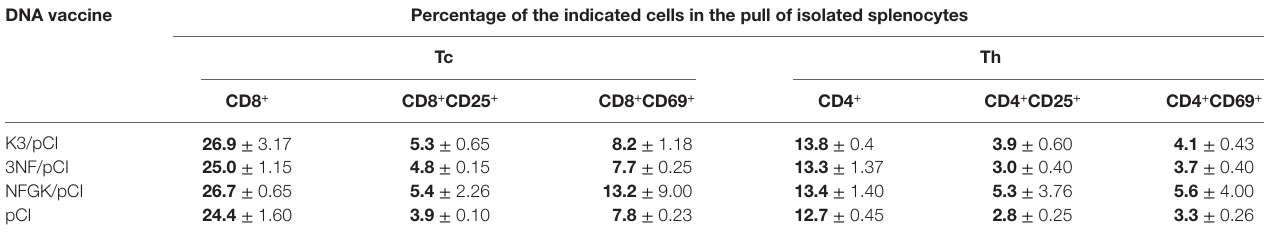
TaBle 2 | Cytokine levels produced by stimulated splenocytes isolated from the mice immunized with the tested variants of the DNA vaccine. iFn γ (pg) TnF (pg) K3/pCI 1,236 ± 333 960 ± 274 964 ± 520 53 ± 22 The results are means (in bold) from three individuals (n = 3) with SDs indicated.